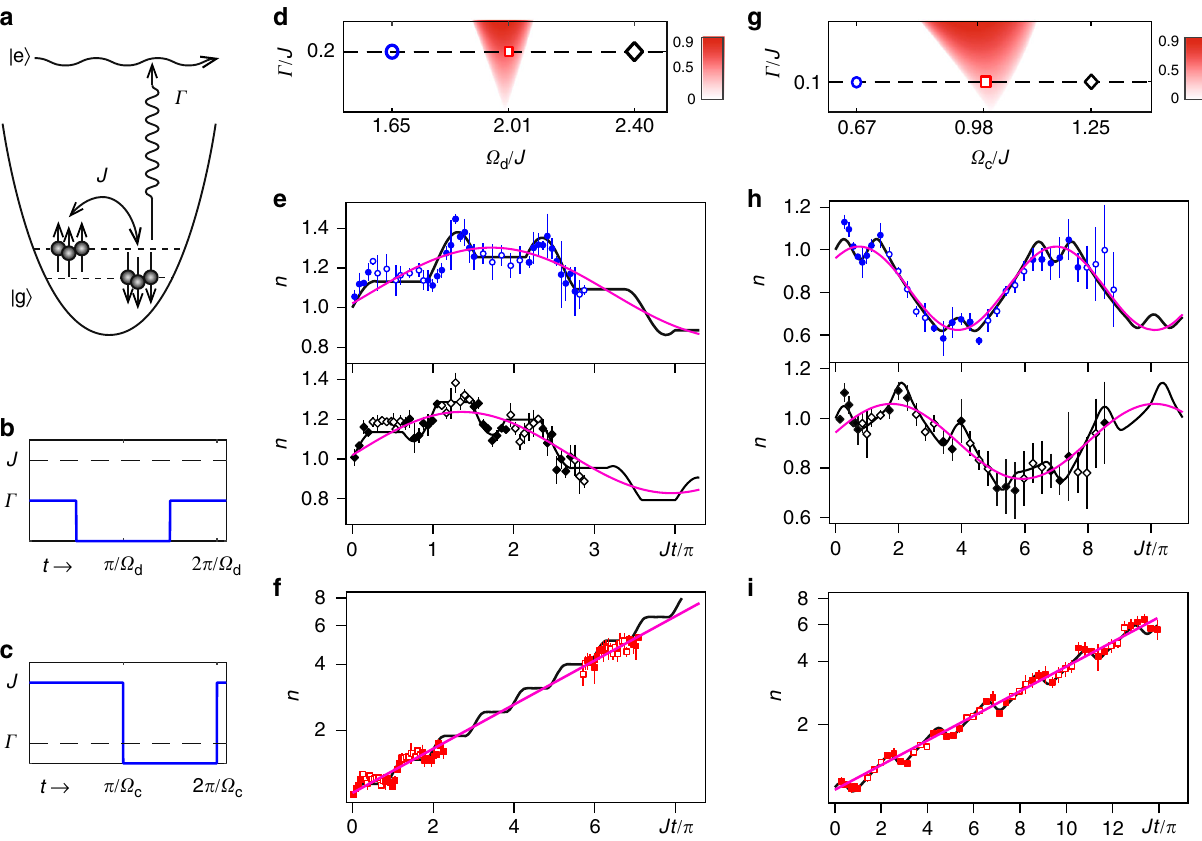
Fig. 1 The parity-time transitions induced by time-periodic modulations. a Experimental setup. An RF fi eld is used to couple the two-spin states. A resonant optical beam is used to generate spin-dependent dissipation (atom loss) in the | ↓ 〉 state. b Γ ( t ) for time-periodic dissipation. c J ( t ) for time-periodic coupling. d – f Time-periodic dissipation: d The phase diagram near the primary resonance. The red color region represents the PT -symmetric broken (PTSB) phase with (| μ + | − | μ − |)/(| μ + | + | μ − |) as the value of the color density, as the following fi gures. e n ( t ) of the PT -symmetric (PTS) phase at Ω d / J = 1.65 (blue circles) and Ω d / J = 2.40 (black diamonds). f n ( t ) of the PTSB phase at Ω d / J = 2.01 (red boxes). g – i Time-periodic coupling: g The phase diagram near the primary resonance. h n ( t ) of the PTS phase at Ω d / J = 0.67 (blue circles) and Ω d / J = 1.25 (black diamonds). i n ( t ) of the PTSB phase at Ω d / J = 0.99 (red boxes). In e , f , h , i , the data with solid shapes corresponds with the dissipation (coupling) on, and the data with empty shapes are with the dissipation (coupling) off. In all fi gures, the black curves are the numerical simulation without free parameter, and the pink curves are the sinusoidal (for PTS) or exponential (for PTSB) fi tting. J = π × 2.15 kHz for all data presented in this paper if not mentioned. The error bars are the standard deviation of